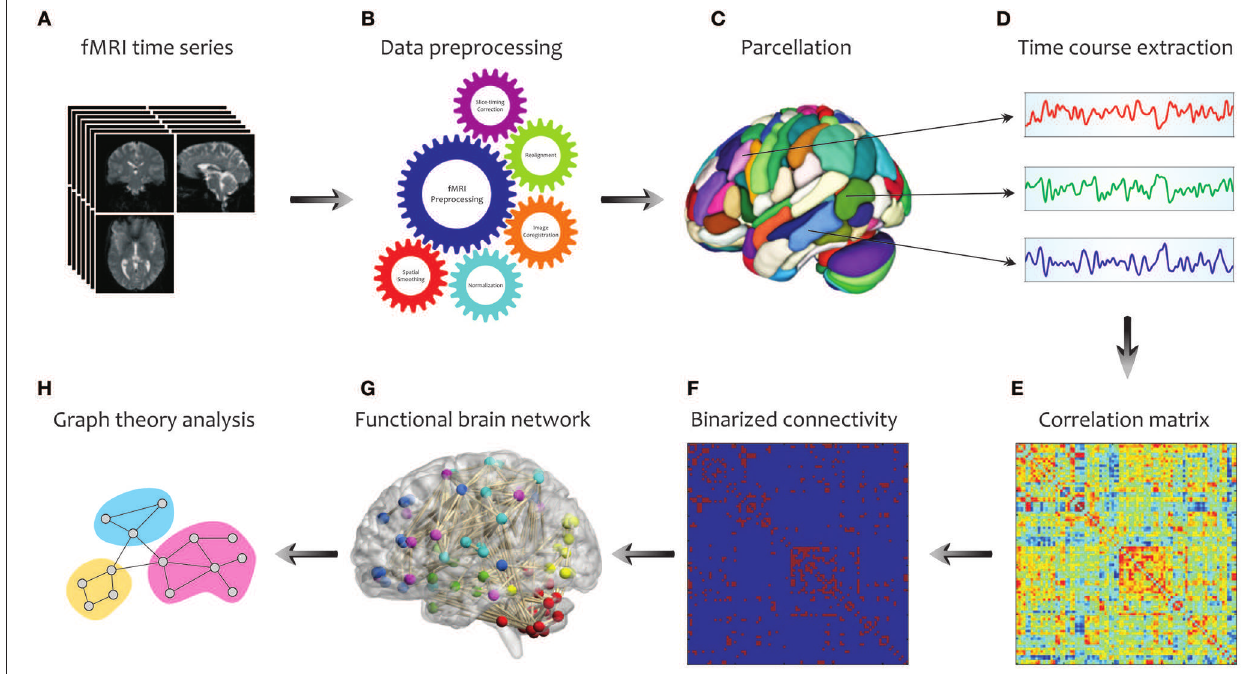
FIGURE 3 | Schematic representation of brain network construction and graph theoretical analysis using fMRI data. After processing (B) the raw fMRI data (A) and division of the brain into different parcels (C) , several time courses are extracted from each region (D) so that they can create the correlation matrix (E) . To reduce the complexity and enhance the visual understanding, the binary correlation matrix (F) , and the corresponding functional brain network (G) are constructed, respectively. Eventually, by quantifying a set of topological measures, graph analysis is performed on the brain’s connectivity network (H)